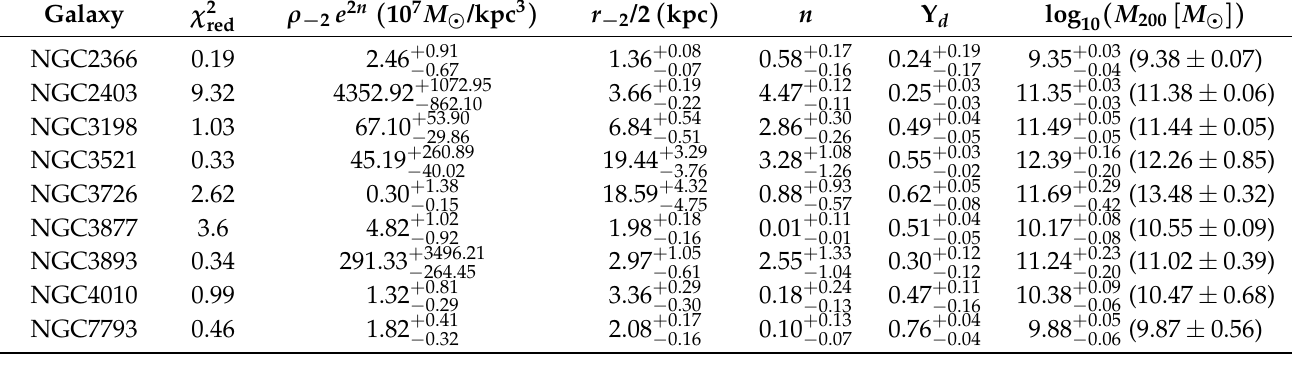
Table 2. For Einasto model, from left to right: Name of LSB galaxies of the SPARC catalog under study, the reduced χ 2 , the density at r = 0, r 0 = r − 2 /2, the spectral index n , Υ d parameter, and M 200 is the dark matter (DM) mass within a radius r 200 in which the density is ρ 200 ( r 200 ) (200 times the critical density of the universe). The values in parentheses in the last column are those halo mass reported in [38].